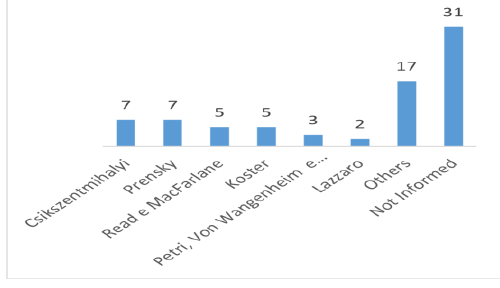
Figure 6. Authors Cited as a Basis for